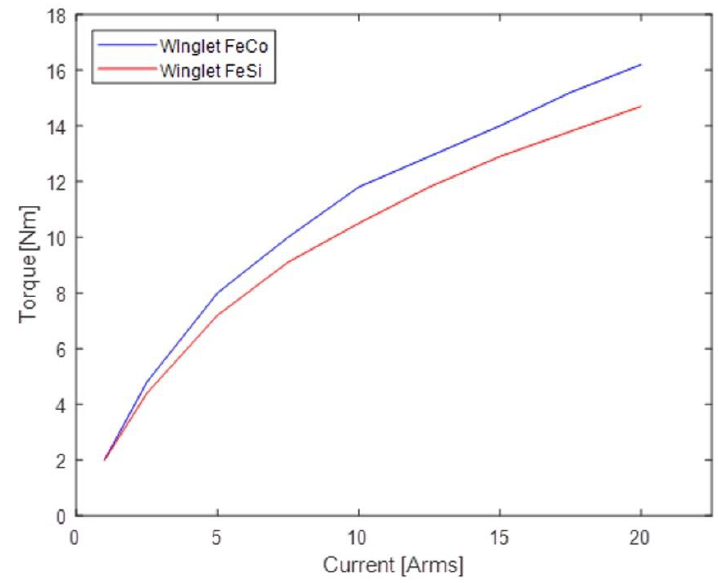
Figure 9. Winglet torque comparison between FeCo and FeSi stators.